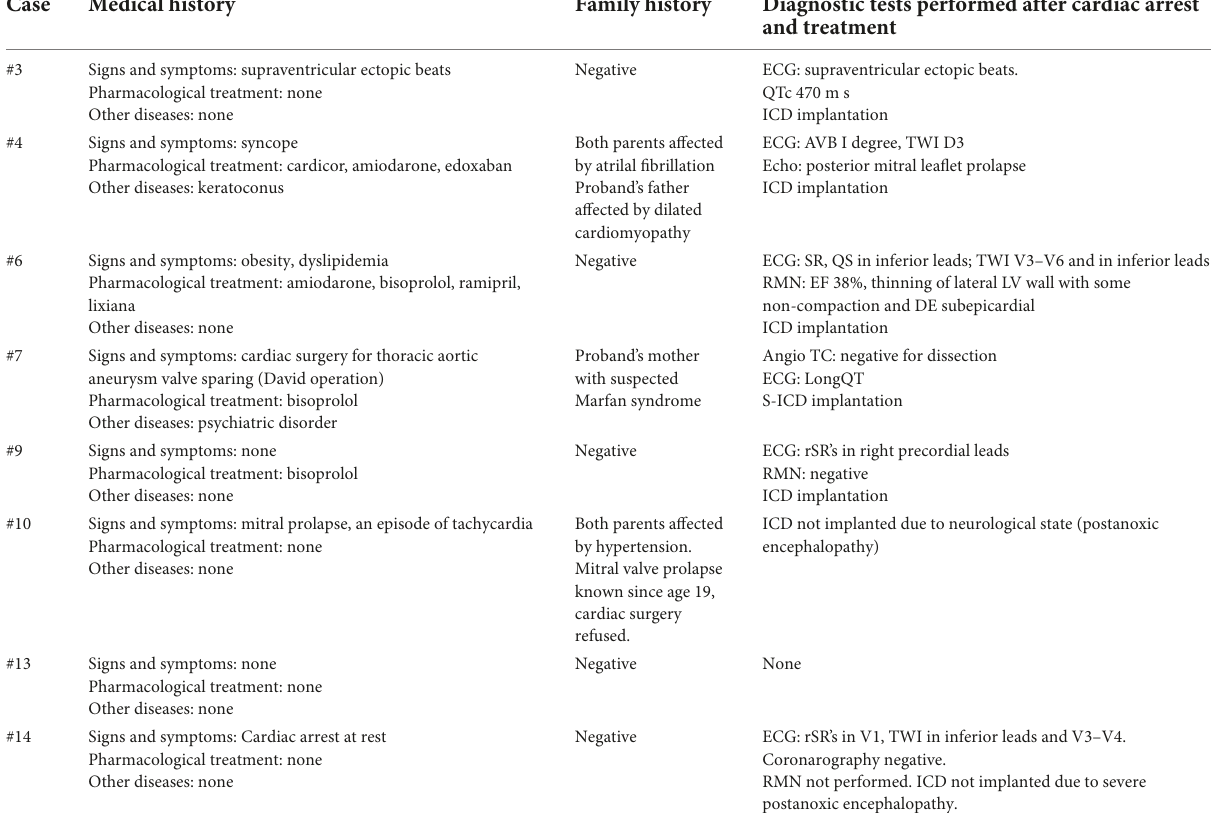
TABLE 2 Data regarding past medical history and family history of Tuscany registry of sudden cardiac death (ToRSADE) survived